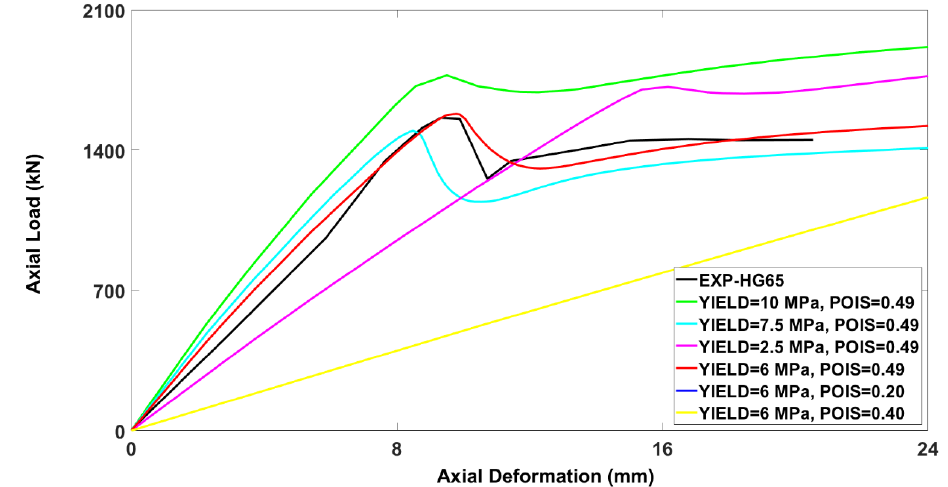
Figure 12. Calibration of control specimen (HG-65) for properties of rubber